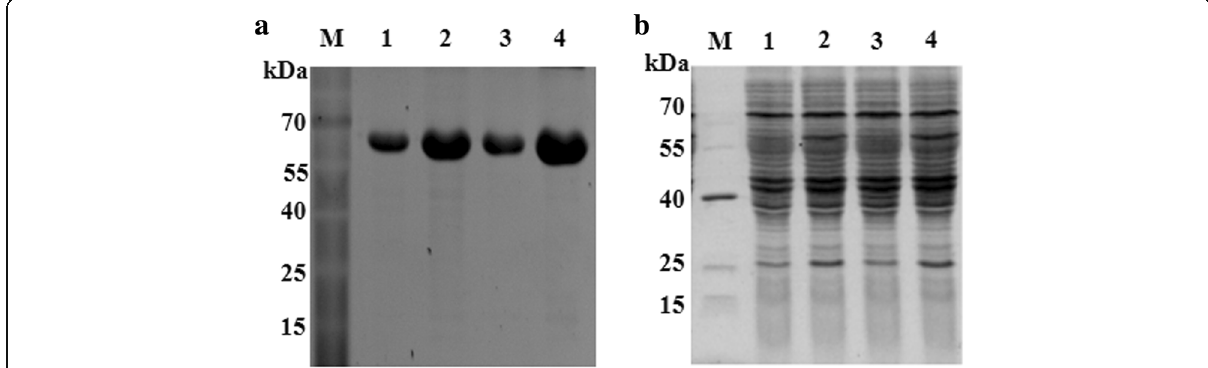
Fig. 1 SDS-PAGE analysis of PLRV-MP recombinant protein. a Lane M: PageRuler Prestained Protein Ladder, and lanes 1 – 4: Purified PLRV-MP recombinant protein. b Induced expression of PLRV-MP recombinant protein. Lanes 1, 3: Non-induced bacterial lysate, and lanes 2, 4: IPTG-induced